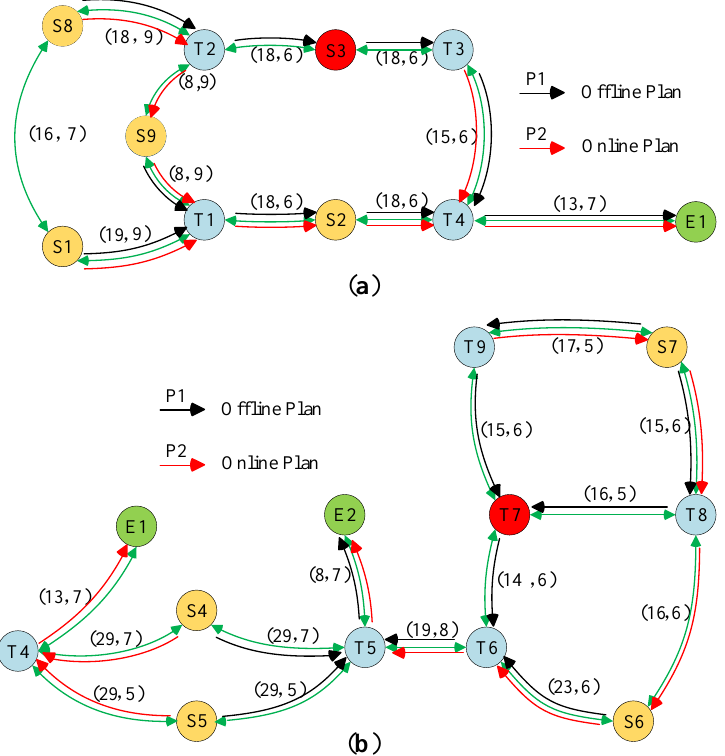
Figure 10. The results of dynamically optimizing the route ( a ) node S3 was simulated with fire; ( b ) node T7 was simulated with sudden